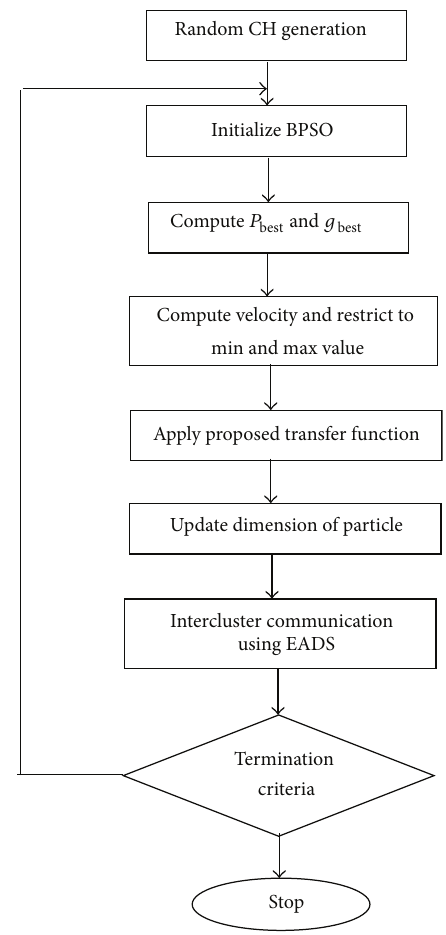
Figure 2: Proposed system for optimal cluster formation and CH